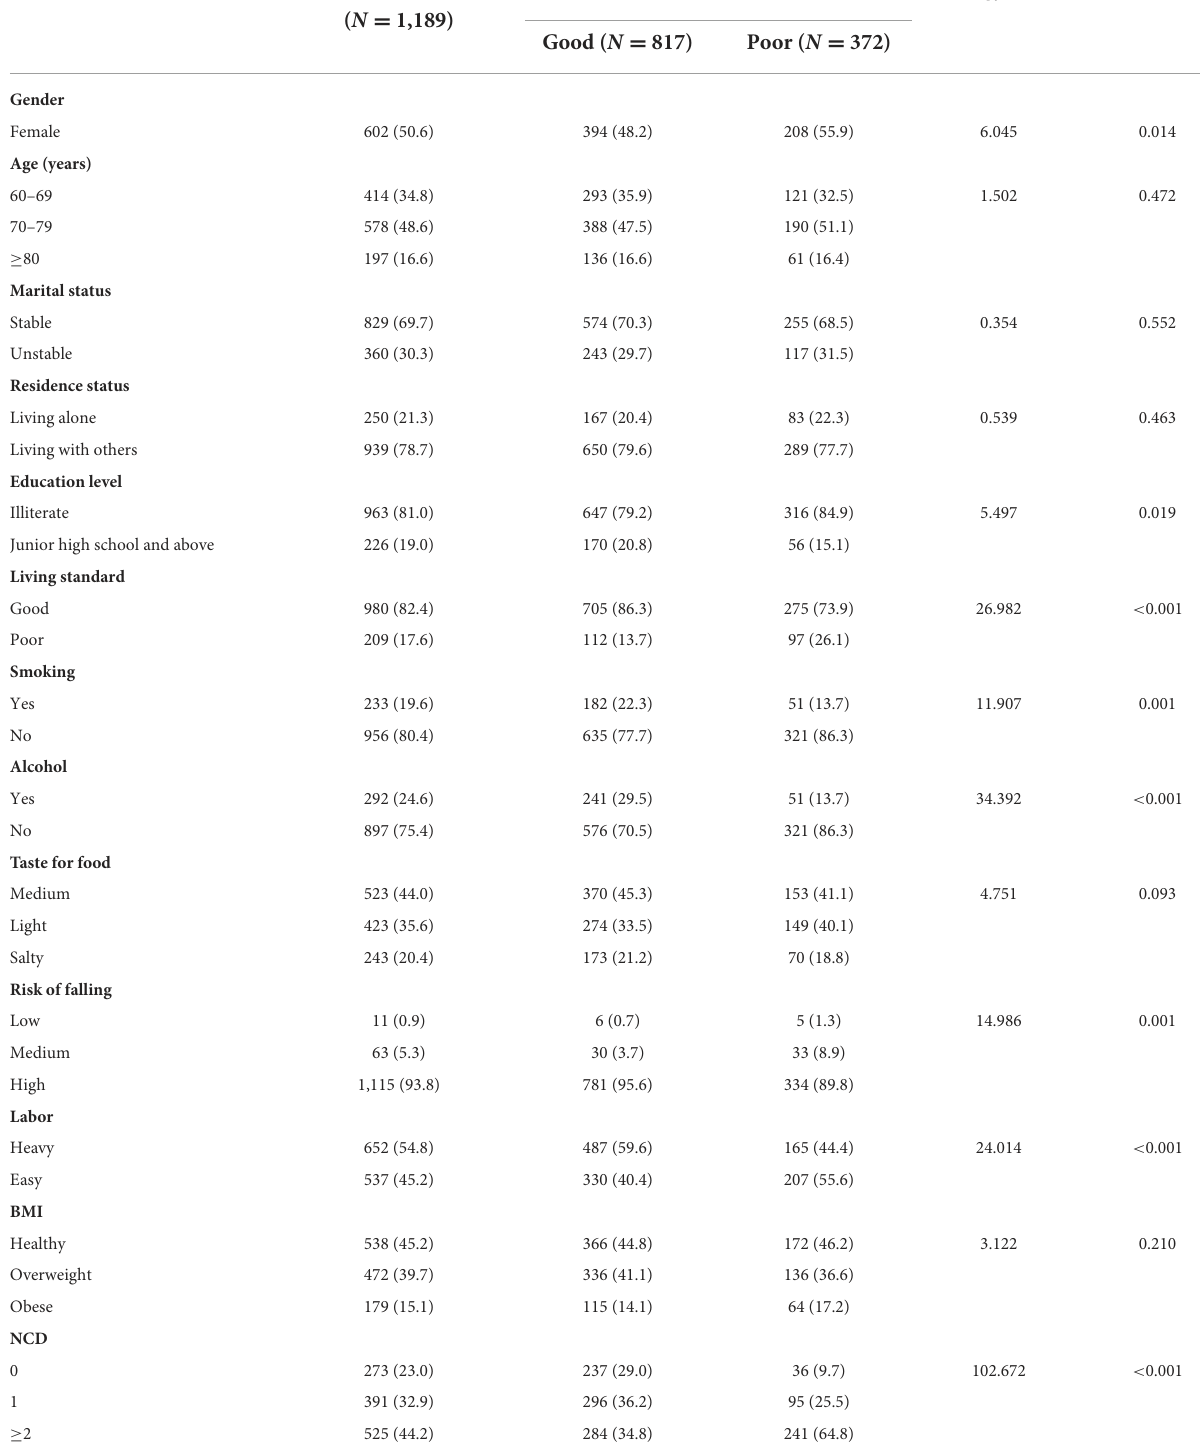
TABLE 1 General characteristics of the respondents ( N =